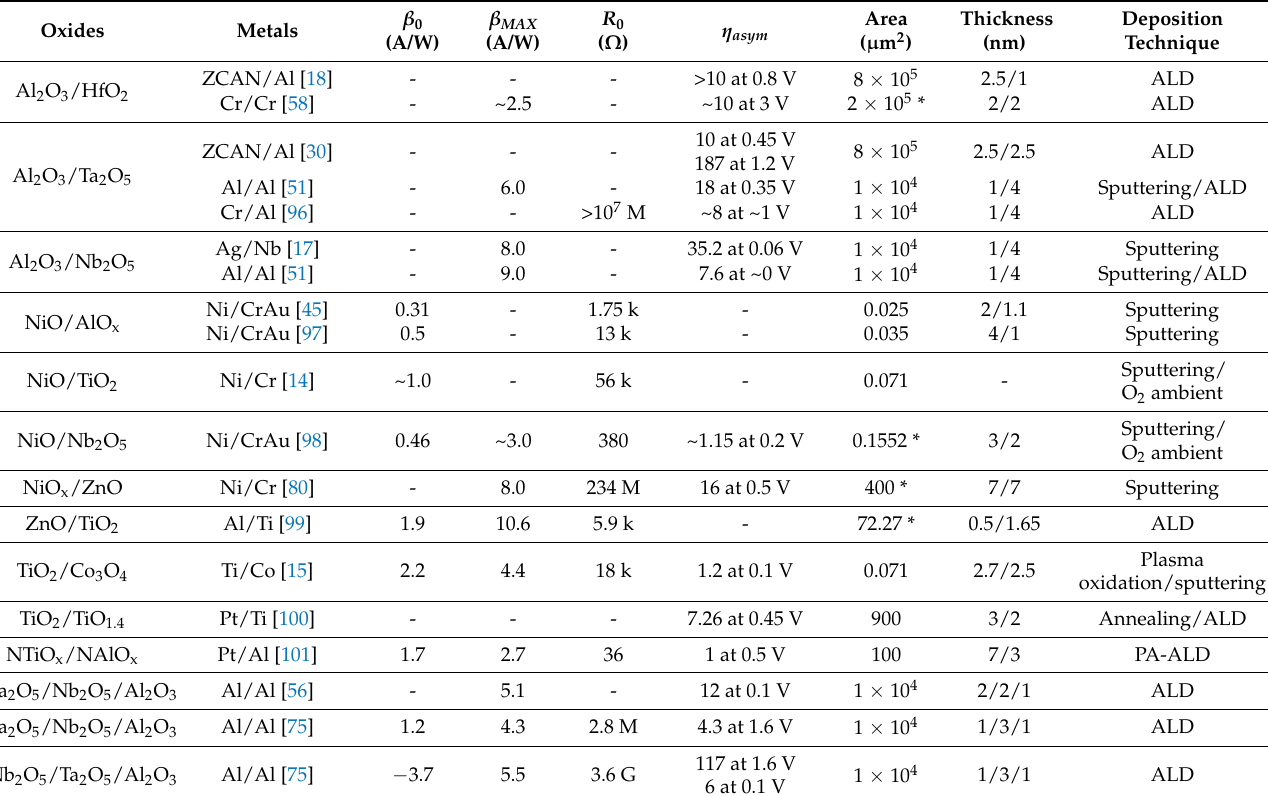
Table 3. A summary of device and rectification parameters for multiple insulator MI n M diodes, n = 1, 2 including device area, oxide thickness in the insulator stack and oxide deposition technique.